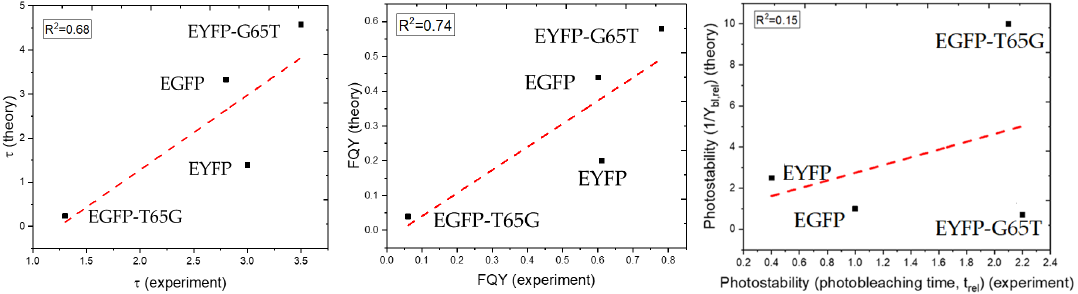
Figure 9. Correlation between theoretical and experimental apparent fluorescence lifetimes (left), FQY (middle), and the rate of bleaching (right).